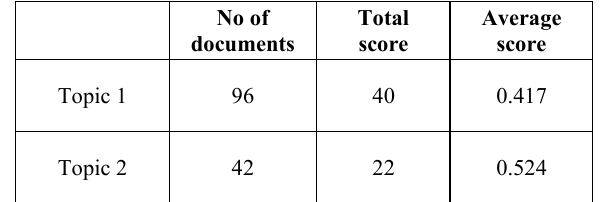
Table 6. Summary statistics on the sentiment scores for each topic in